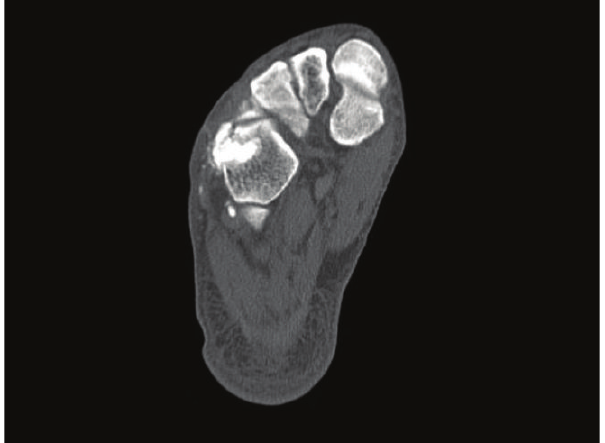
Figure 6: Defect area filled with artificial